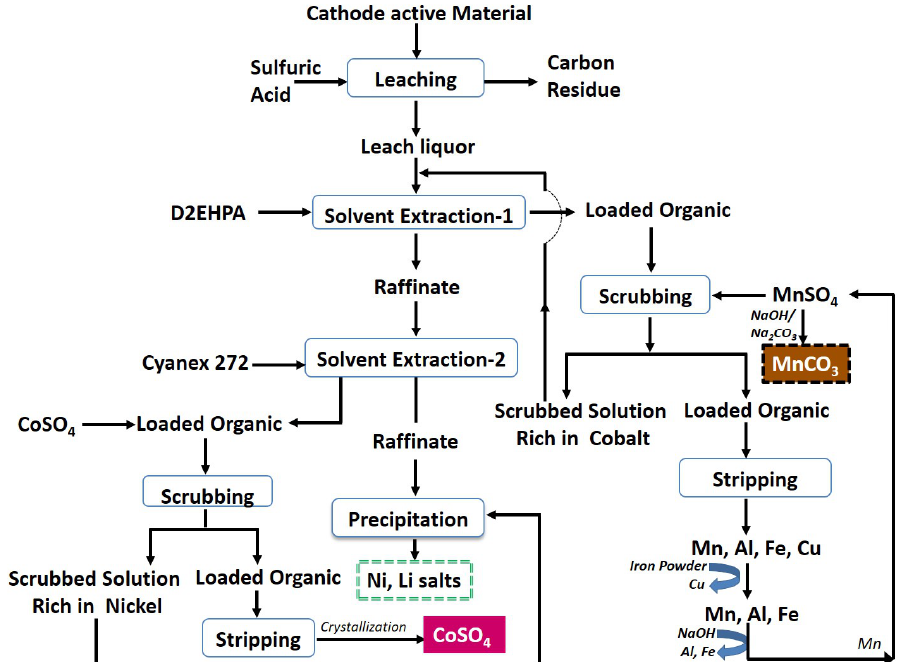
Figure 8. Process flowsheet to recover high pure cobalt and all metals present in cathode active materials of